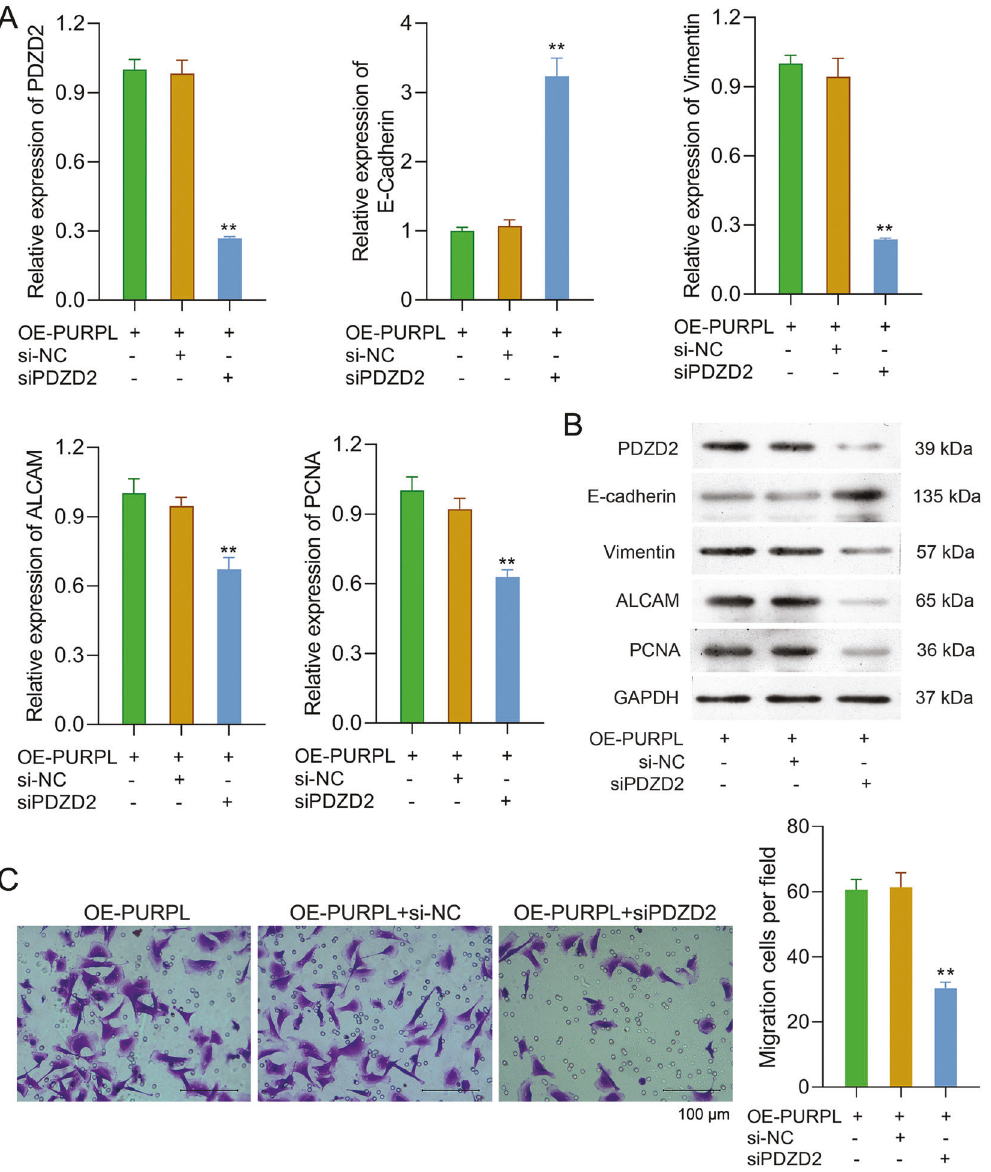
Fig. 6 Silence of PDZD2 weakened the in fl uence of PURPL overexpression on MG-63 cell EMT and TAMs migration. MG-63 cells were subjected to OE-PURPL and/or siPDZD2 transfection. A , B The mRNA and protein expressions of PDZD2, E-cadherin, vimentin, ALCAM, and PCNA in MG-63 cells were tested via qPCR and western blotting. C TAMs were cultivated into the upper- chamber, while MG-63 cells were put into the lower- chamber. Forty-eight hours later, the migration of TAMs was tested. **P < 0.01 vs . OE-PURPL + si-NC group.